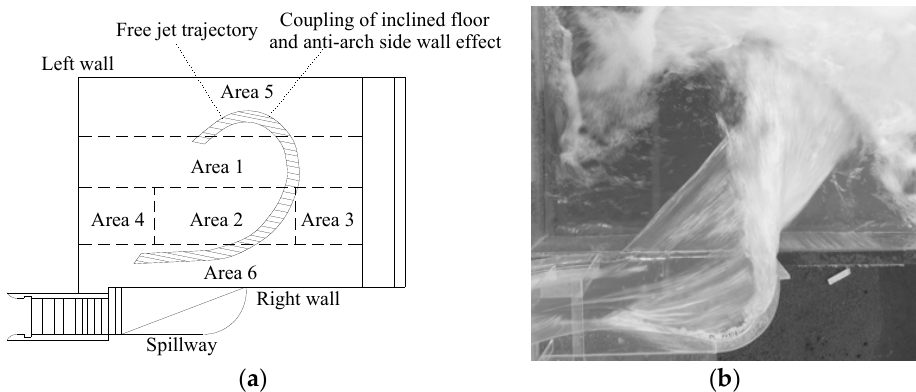
Figure 9. Flow jet impact in the plunge pool: ( a ) sketch plane view; ( b ) experimental image ( α = 60°).